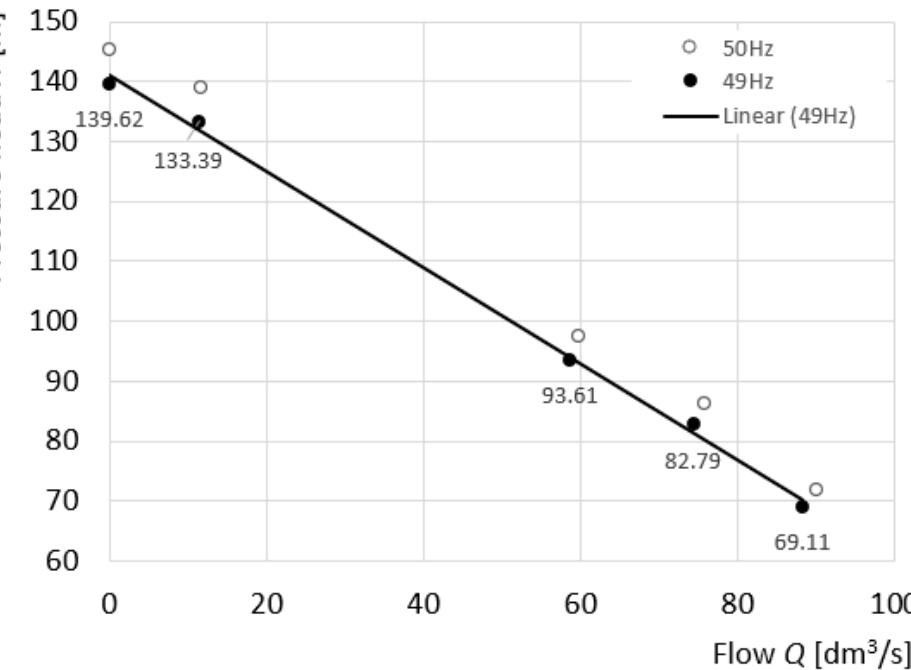
Figure 6. The experimentally determined curve which relates pressure head and flow of the SP 270-3A G pump recalculated for 49 Hz.